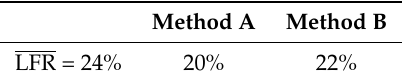
Table 1. Calculated laminar flow reduction compared between the manual transition line evaluation and the two introduced image processing